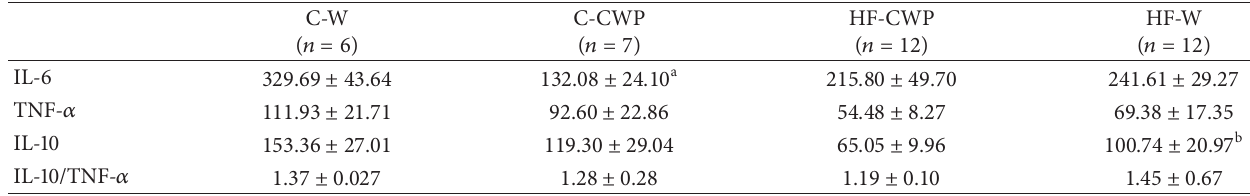
Table 4: Serum of triacylglycerol, total cholesterol, glucose, insulin, and adiponectin of mice treated with high fat diet (HF) or control normocaloric (C) associated with gavage of coacervate (CWP) or water (W). C-W C-CWP HF-CWP HF-W Serum measurements ( 𝑛 = 10 ) ( 𝑛 = 11 ) ( 𝑛 = 17 ) ( 𝑛 = 17 ) Triacylglycerol (mg/dL) 133.37 ± 4.28 127.09 ± 4.85 129.30 ± 4.31 141.55 ± 3.94 b,d Total cholesterol (mg/dL) 128.75 ± 4.22 129.46 ± 4.76 128.99 ± 3.35 150.03 ± 6.00 LDL (mg/dL) 68.81 ± 1.75 73.18 ± 3.07 75.66 ± 1.64 80.3 ± 3.28 VLDL (mg/dL) 26.32 ± 0.86 25.42 ± 0.97 25.86 ± 0.86 28.92 ± 0.76 b,d HDL (mg/dL) 33.62 ± 1.75 36.71 ± 3.07 35.13 ± 1.64 40.83 ± 3.28 Glucose (mg/dL) 100.27 ± 2.69 89.84 ± 4.45 100.80 ± 3.58 105.28 ± 3.47 Insulin (ng/mL) 0.51 ± 0.03 0.64 ± 0.01 0.65 ± 0.01 0.75 ± 0.02 b HOMA-IR 0.89 ± 0.26 0.97 ± 0.15 1.12 ± 0.21 1.25 ± 0.19 b Adiponectin (ng/mL) 3.55 ± 0.47 3.98 ± 0.26 4.04 ± 0.10 3.34 ± 0.29 d Lipopolysaccharides (EU/mL) 2.58 ± 0.98 1.61 ± 0.66 1.49 ± 0.50